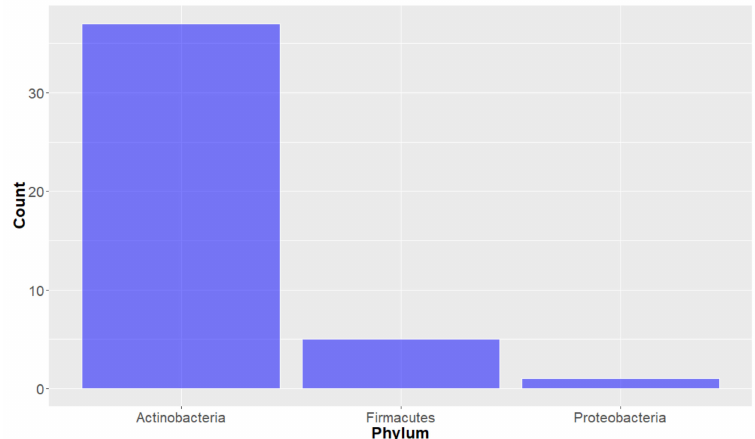
Figure 5. Number of natural products isolated from deep-sea marine bacteria, by